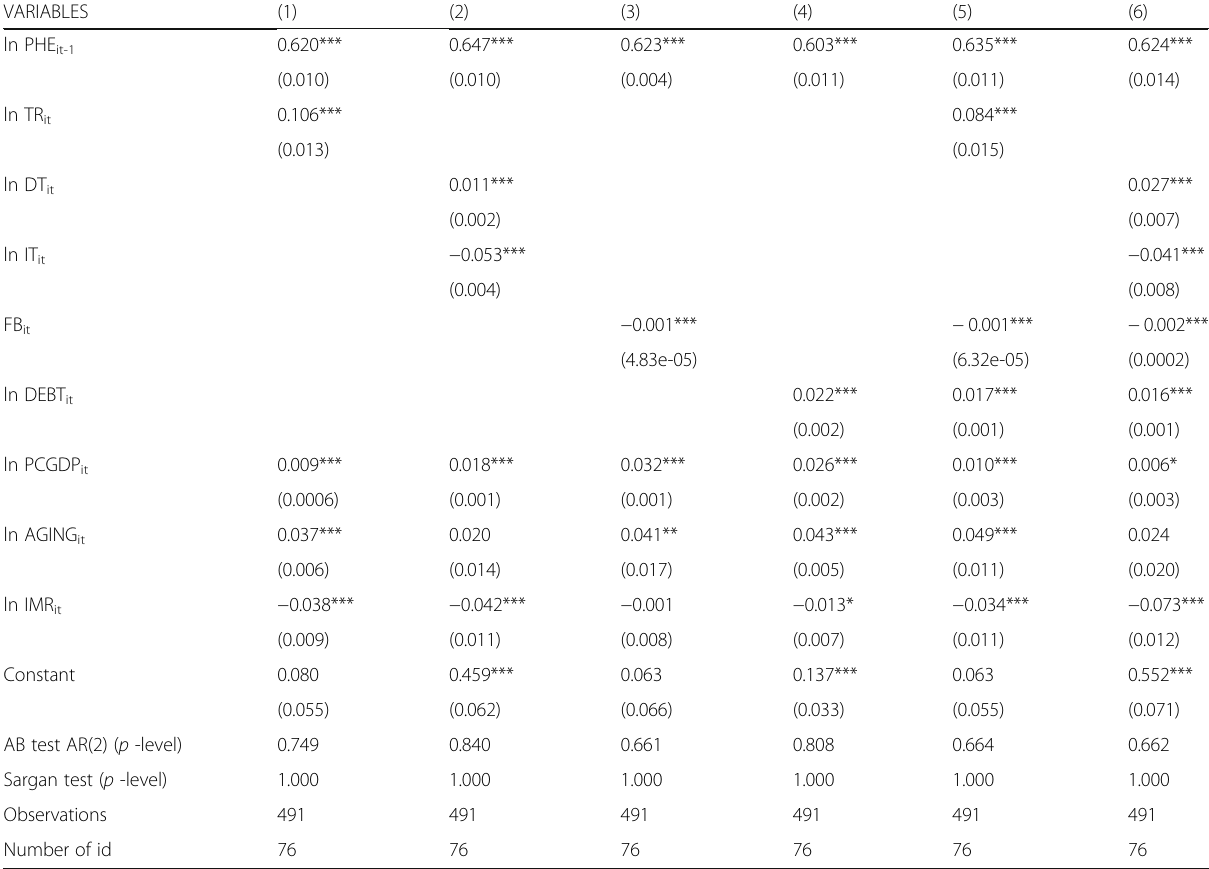
Table 2 Dynamic System GMM Regression Model (Pre-Global Financial Crisis)